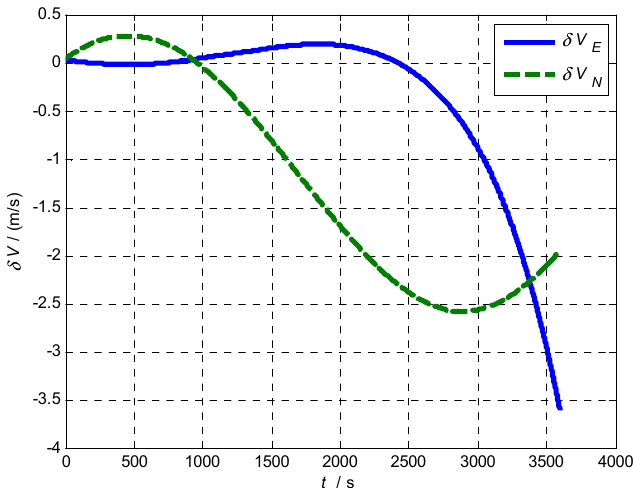
Figure 11. Velocity errors of SINS on a vehicle.